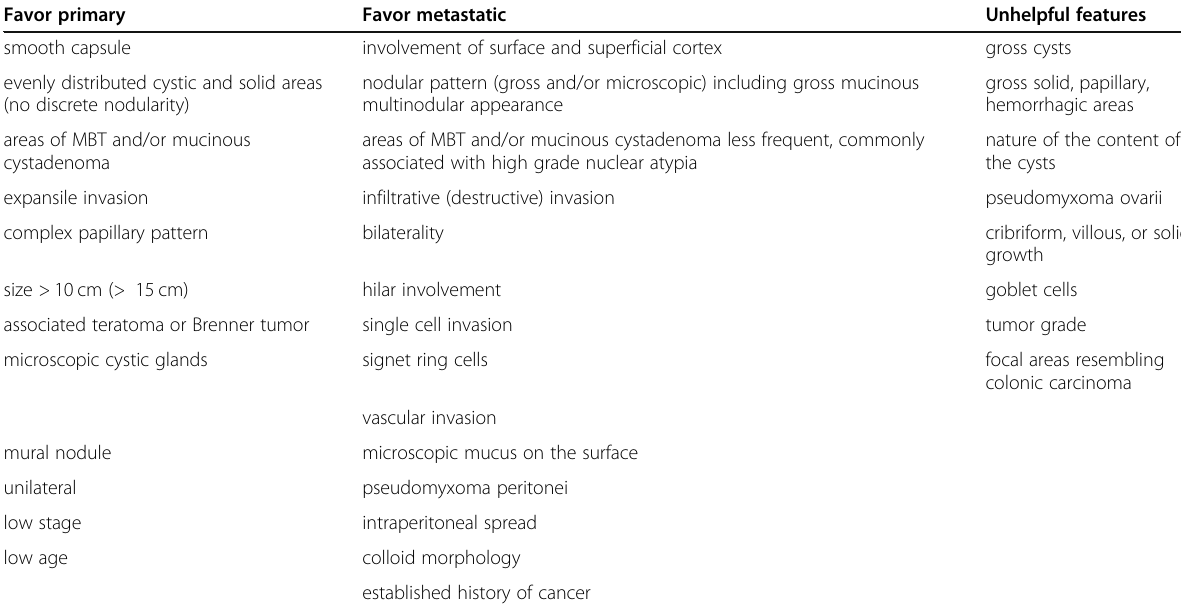
Table 2 List of morphological features of primary and metastatic ovarian carcinomas Favor